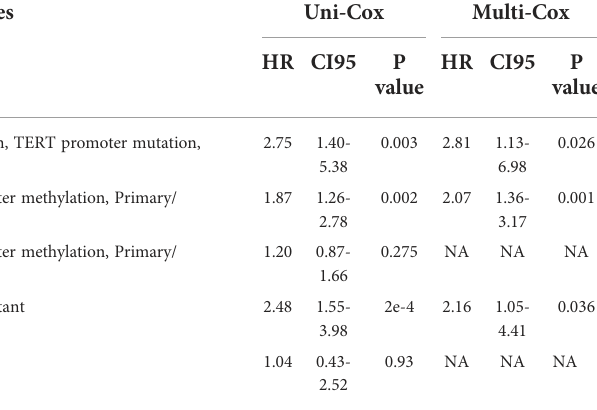
multivariate regression analysis found a signi fi cant positive correlation between MRGPI and the fraction of M2 macrophages (Figure 4D), validating the association between MRGPI and alternative activation of TAMs in GBM TME.